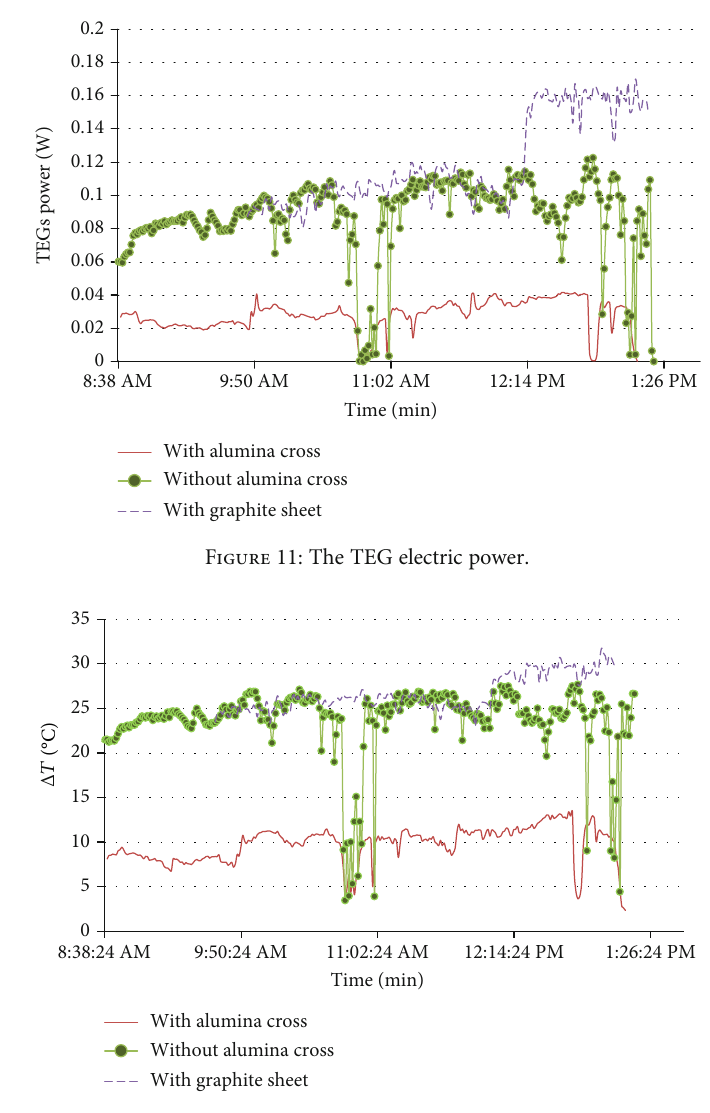
Figure 12: The temperature di ff erences between TEG